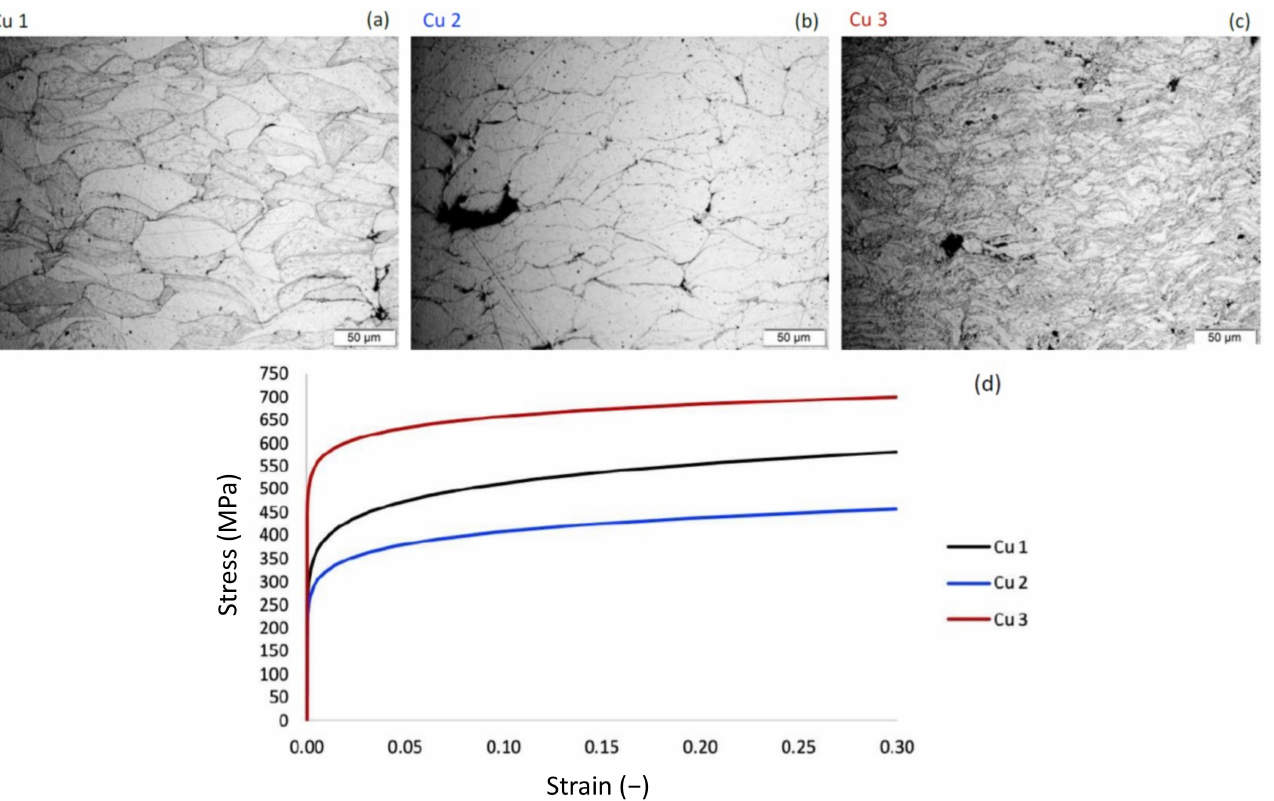
Figure 3. ( a – c ). Optical micrographs of the cross-sectional view of the cold sprayed samples created from powders Cu 1–3. ( d ). Presentation of the average true stress vs. true strain curves determined via flat-punch indentation